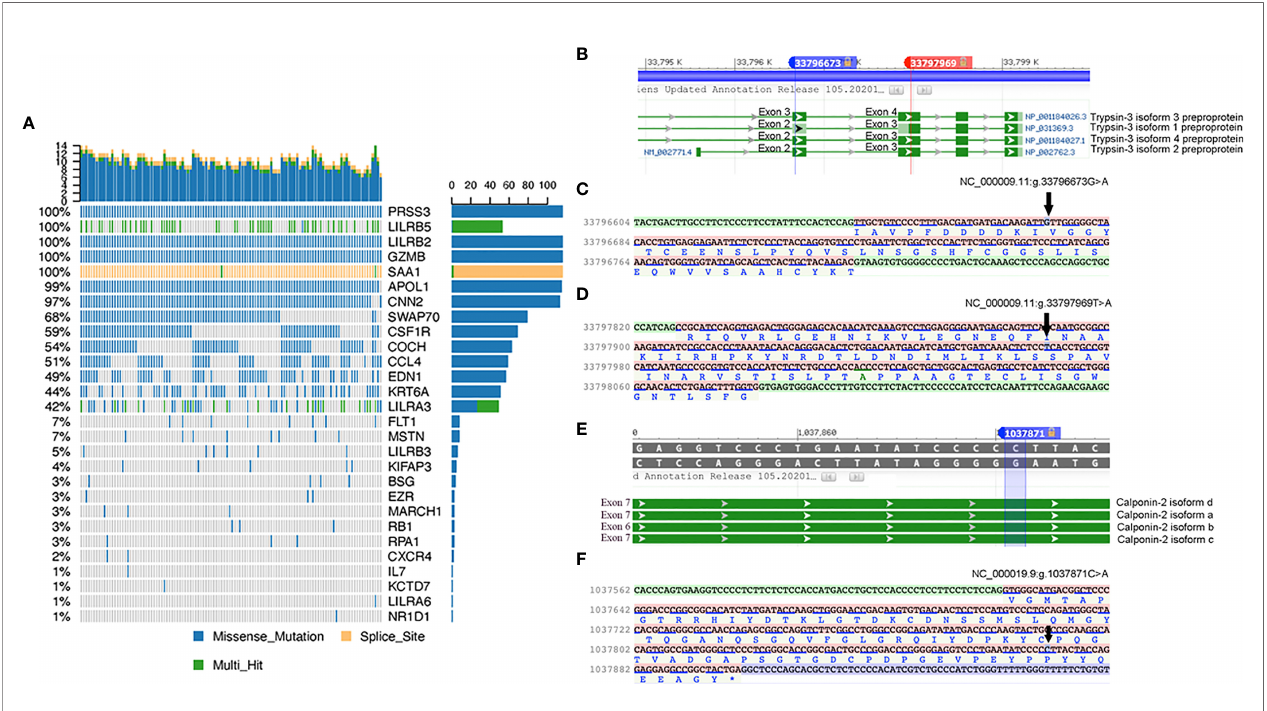
FIGURE 3 | (A) Characteristics of SNPs of 30 immune-related candidate pathogenesis genes. The details of missense mutations, splice site mutations, and multihit mutations in 116 sporadic sarcoidosis patients are presented as percentages. (B) Two missense mutations in PRSS3 of transcript isoforms. (C) and (D) Mutation details of rs76740888 and rs149664918 on nucleotide sequence and amino acid sequence. (E) Missense mutation of rs78251590 in the CNN2 gene. (F) Mutation details of rs78251590 on nucleotide and amino acid